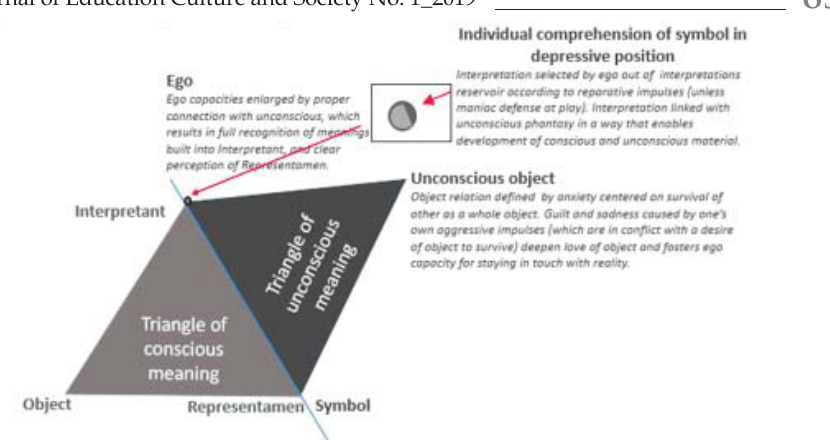
Figure 7. (cid:54)(cid:70)(cid:75)(cid:72)(cid:80)(cid:72)(cid:3)(cid:83)(cid:85)(cid:72)(cid:86)(cid:72)(cid:81)(cid:87)(cid:76)(cid:81)(cid:74)(cid:3)(cid:70)(cid:82)(cid:80)(cid:69)(cid:76)(cid:81)(cid:72)(cid:71)(cid:3)(cid:89)(cid:76)(cid:72)(cid:90)(cid:86)(cid:3)(cid:82)(cid:73)(cid:3)(cid:38)(cid:75)(cid:68)(cid:85)(cid:79)(cid:72)(cid:86)(cid:3)(cid:51)(cid:72)(cid:76)(cid:85)(cid:70)(cid:72)(cid:3)(cid:11)(cid:51)(cid:72)(cid:76)(cid:85)(cid:70)(cid:72)(cid:15)(cid:3)(cid:20)(cid:28)(cid:19)(cid:25)(cid:15)(cid:3)(cid:20)(cid:28)(cid:28)(cid:27)(cid:12)(cid:15)(cid:3)(cid:68)(cid:81)(cid:71)(cid:3) (cid:48)(cid:72)(cid:79)(cid:68)(cid:81)(cid:76)(cid:72)(cid:3)(cid:46)(cid:79)(cid:72)(cid:76)(cid:81)(cid:3)(cid:11)(cid:46)(cid:79)(cid:72)(cid:76)(cid:81)(cid:15)(cid:3)(cid:20)(cid:28)(cid:22)(cid:19)(cid:15)(cid:3)(cid:20)(cid:28)(cid:23)(cid:27)(cid:12)(cid:3)(cid:82)(cid:81)(cid:3)(cid:86)(cid:92)(cid:80)(cid:69)(cid:82)(cid:79)(cid:15)(cid:3)(cid:90)(cid:75)(cid:72)(cid:81)(cid:3)(cid:71)(cid:72)(cid:83)(cid:85)(cid:72)(cid:86)(cid:86)(cid:76)(cid:89)(cid:72)(cid:3)(cid:83)(cid:82)(cid:86)(cid:76)(cid:87)(cid:76)(cid:82)(cid:81)(cid:3)(cid:73)(cid:85)(cid:68)(cid:80)(cid:72)(cid:86)(cid:3)(cid:80)(cid:76)(cid:81)(cid:71)(cid:17)(cid:3)